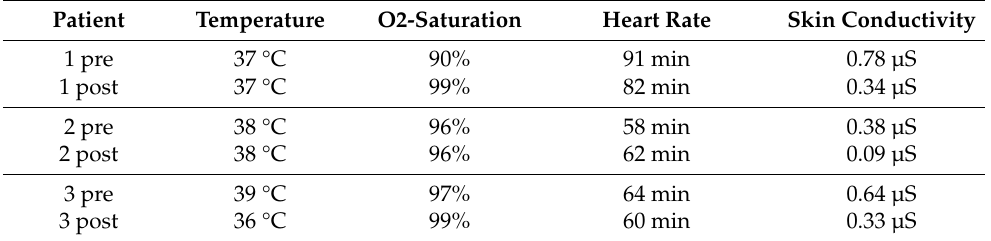
Table 2. Overview of accompanying measurements of all patients in the six-week follow-up.